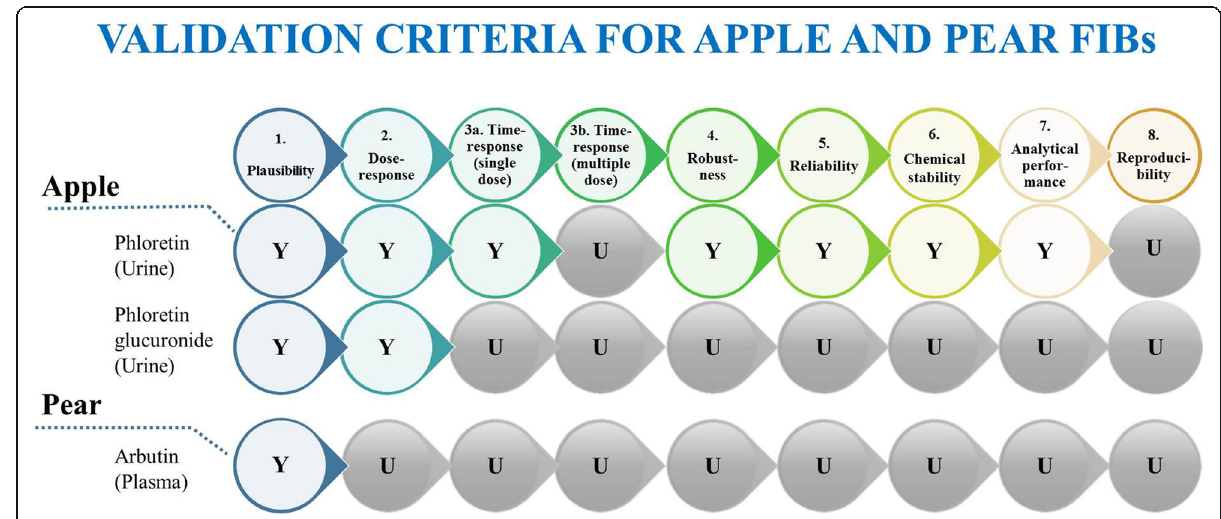
Fig. 3 Overview of the validation process and its application process for candidate BFIs for pome